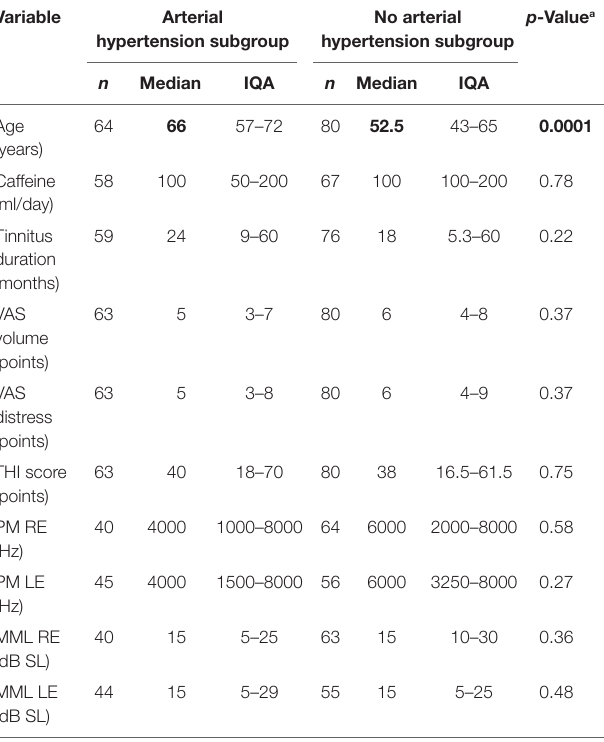
Table 5 | analysis of the numerical variables (age, caffeine consumption, tinnitus duration, Visual analog scale, Tinnitus handicap inventory, Pitch Masking, and Minimum Masking level) according to the subgroups of tinnitus patients (with and without arterial hypertension).